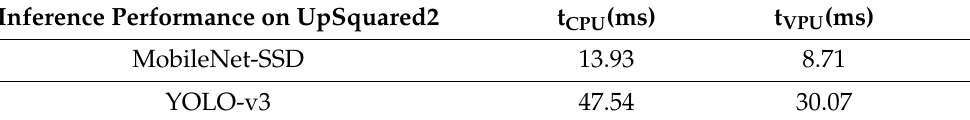
Table 4. Inference computational cost (in ms) for the different algorithms using CPU or